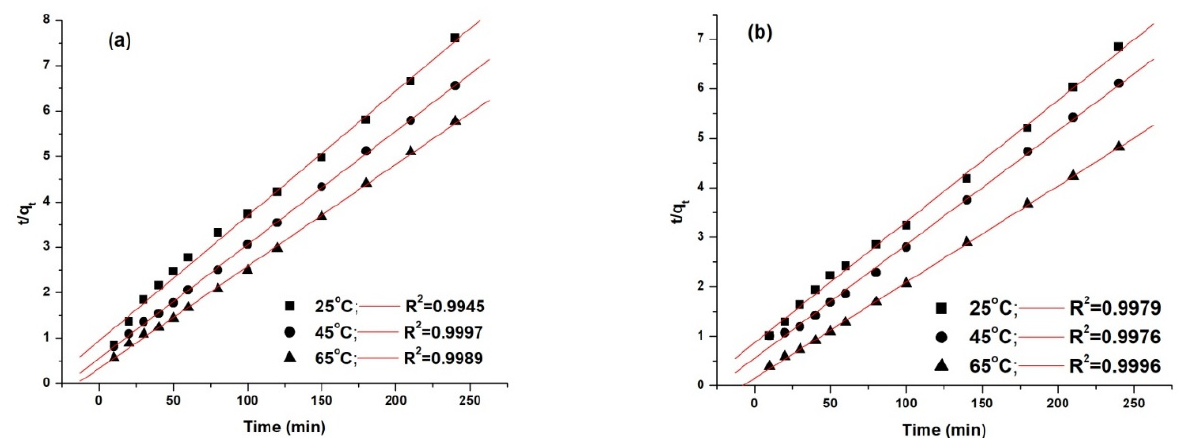
Figure 13. Pseudo second-order kinetic model fitting for the adsorption of AY 42 ( a ) and AR 213 ( b ) onto PM4. Table 8. Kinetic parameters of studied models for adsorption of AY 42 and AR 213 onto PM4. Pseudo First-Order Kinetic Pseudo Second-Order Temp. Model Dye Dye Temp.